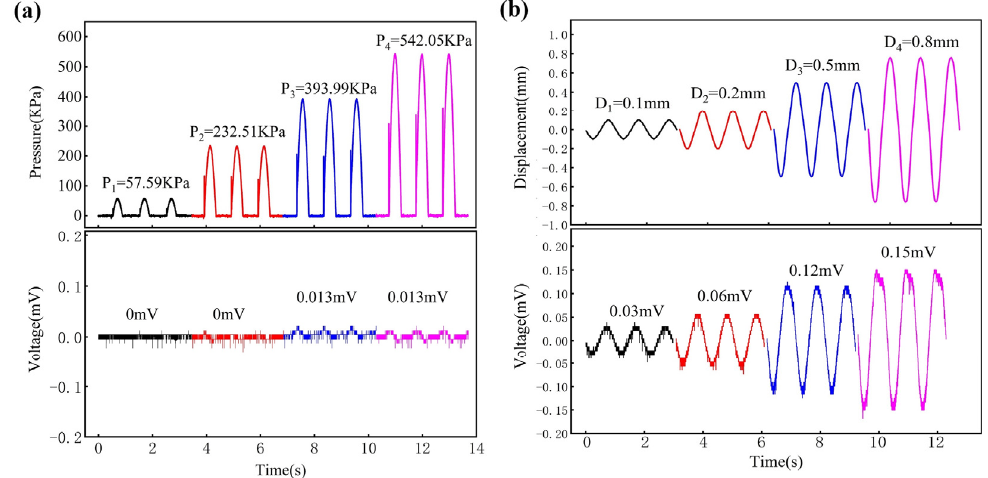
Figure 4. The experimental results of signal source analysis. ( a ) Pressure − applying signal and volt- age response of IPMC sensing layer in compression mode. ( b ) Displacement − applying signal and voltage response of IPMC sensing layer in bending mode.